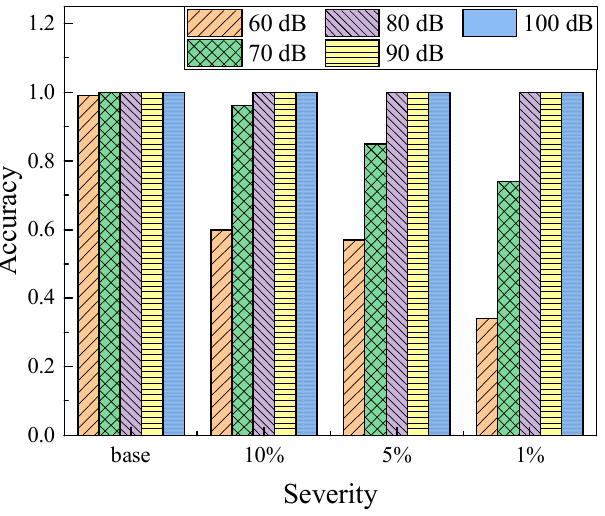
Figure 27. Accuracy with respect to defect severity under various noise levels.